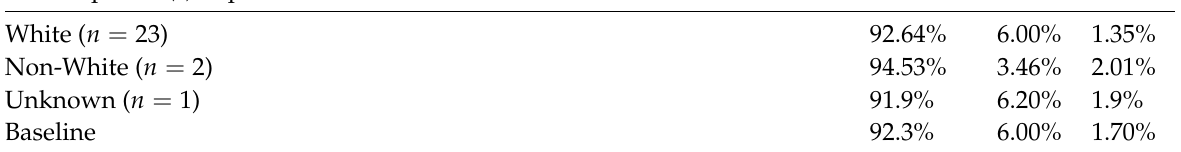
Mean Proportion in Experimental